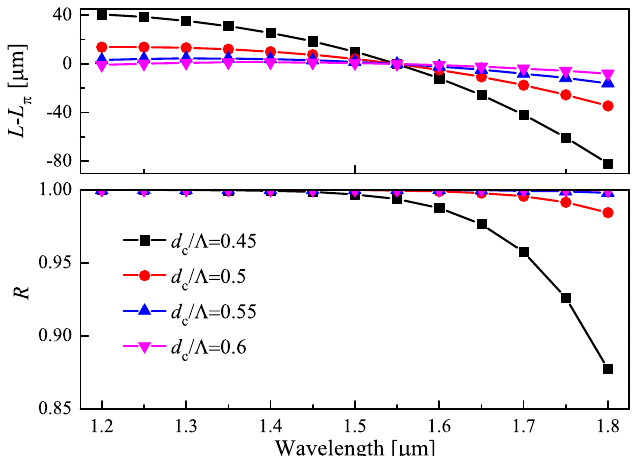
Figure 11. The variation of difference between a fixed device length and the corresponding conversion length ( L − L π ) and the modal hybrid against different operation wavelengths.